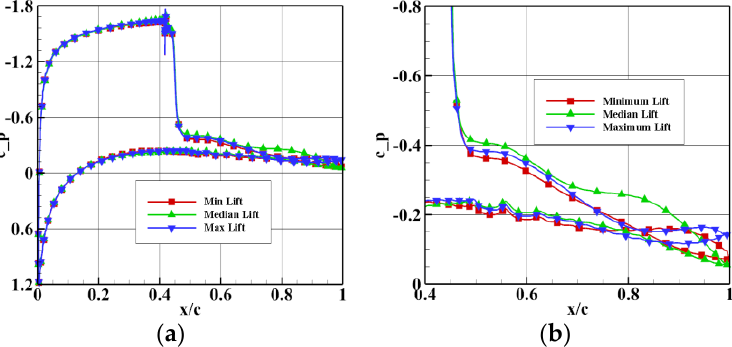
Figure 15. Surface pressure distributions corresponding to maximum/median/minimum lifts with tangential blowing. ( a ) Surface pressure distribution; ( b ) zoomed version.